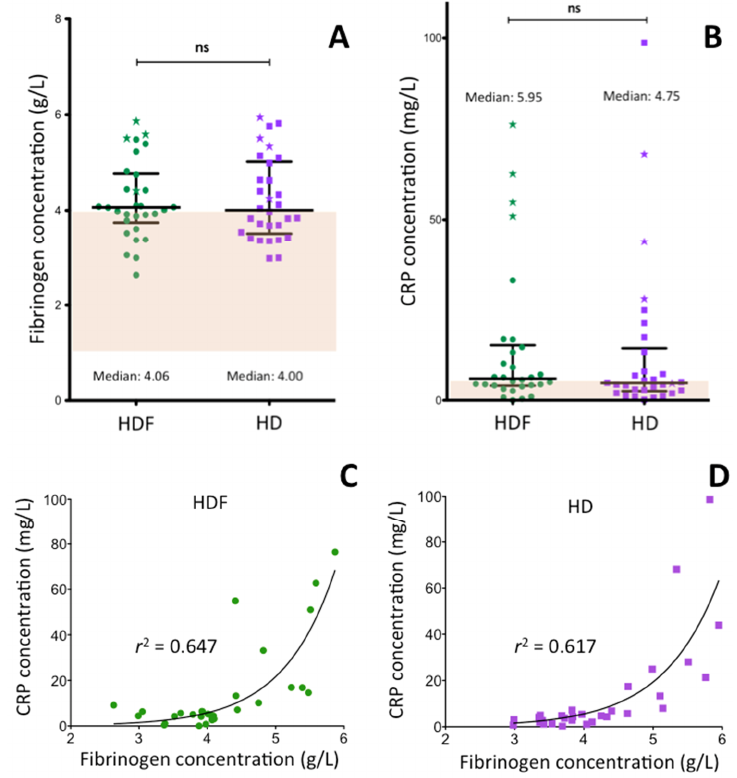
Figure 1. Fibrinogen concentration, C-reactive protein (CRP) level and their relationship in patients with end-stage renal disease. ( A ) Fibrinogen concentration and ( B ) CRP level in patients being on permanent HDF treatment and after switching to HD treatment for two weeks. Longer horizontal lines demonstrate median values (numerical values are also shown), shorter horizontal lines depict the upper and lower limits of interquartile range. The four outliers with CRP level higher than 50 mg / L in the HDF group are labelled by asterisk in both ( A , B ). ( C , D ) demonstrate the relationship between CRP level and fibrinogen concentration in HDF treated patients and after HD treatment, respectively. CRP: C-reactive protein, HDF: hemodiafiltration, HD hemodialysis, ns: not significant, r 2 : coe ffi cients of